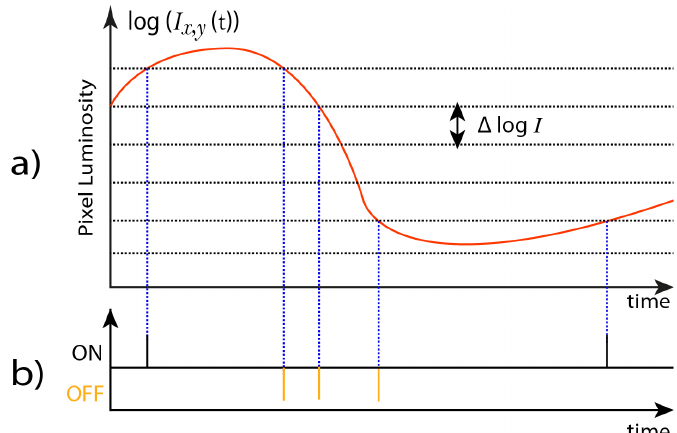
Figure 1. ATIS operation principles. When a pixel’s luminosity change reaches a given threshold ( a ),